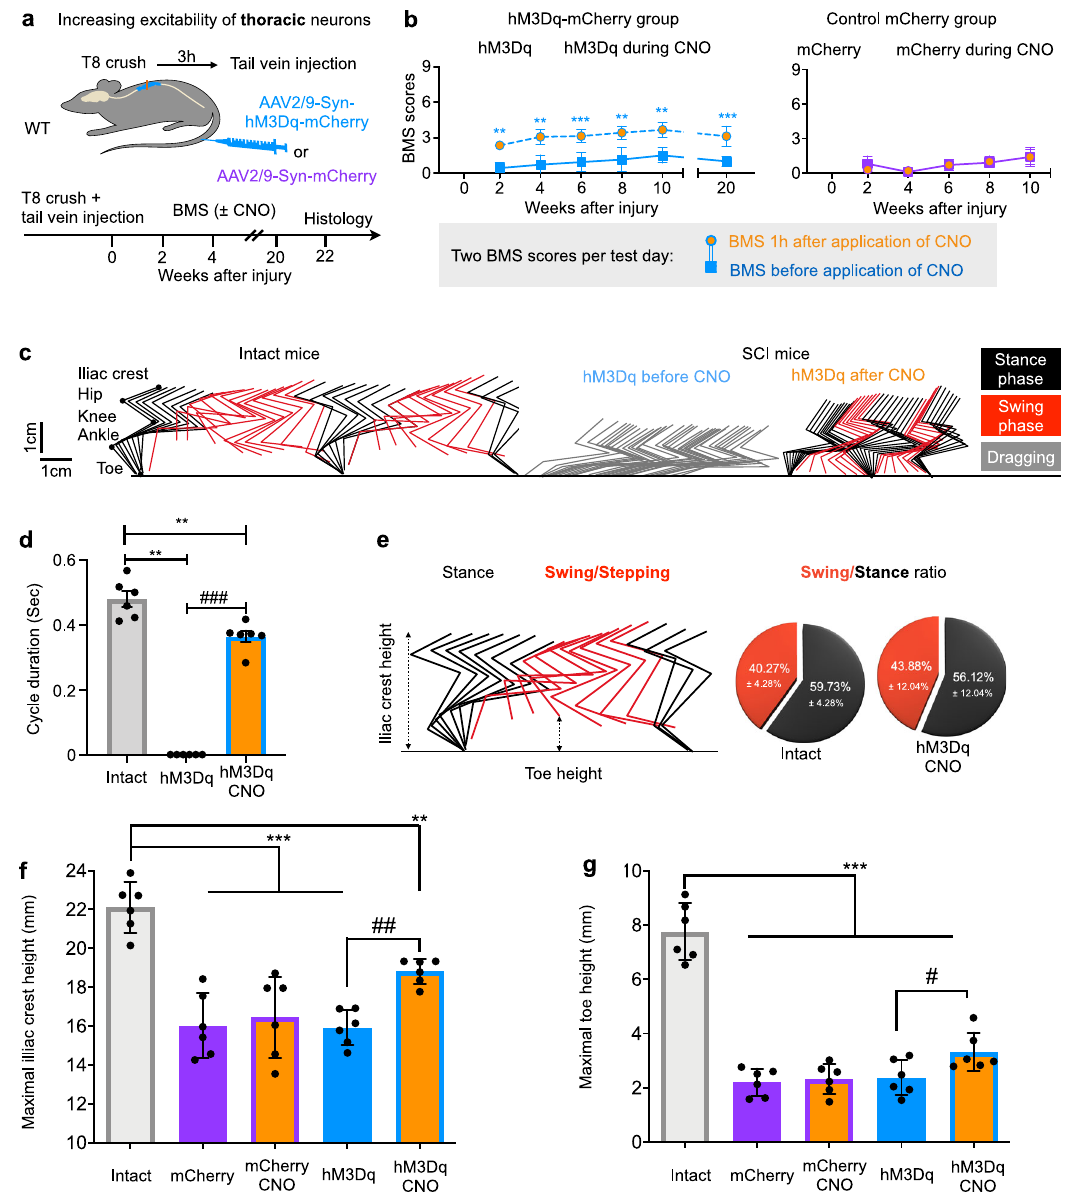
Fig. 2 hM3Dq-assisted activation of thoracic neurons elicits locomotion behaviour after T8 crush. a Experimental schematic. After a T8 crush injury, wild type (WT) mice received a tail vein injection of AAV2/9-Syn-hM3Dq-mCherry or control virus (AAV2/9-Syn-mCherry) and their locomotion behaviour was measured upon CNO administration every 2 weeks after injury. b BMS scores of injured mice with AAVs expressing hM3Dq-mCherry (left) or control mCherry (right) at indicated time points, before and 1 h after administration of 1 mg/kg CNO. hM3Dq-mCherry group: n = 7; Control group: n = 5. Data shown as mean ± SD (and also for other panels). Factorial Repeated Measures ANOVA with 2 within-subjects factors, followed by two-tailed paired t test at each time point. ns: no statistical difference, ** p = 0.0090 (2 weeks); 0.0081 (4 weeks); 0.0012 (8 weeks); 0.0029 (10 weeks), *** p < 0.0001 (6 weeks, 20 weeks). c Stickviews of kinematic hindlimb analysis of intact mouse and mouse with hM3Dq expression before and after CNO injection (1 mg/kg) at 4 weeks after injury. The phases of dragging, stance, or swing were marked in indicated colours. Cycle duration ( d ) and swing/ stance ratio ( e ) of intact mice and spinal cord injured mice with hM3Dq expression. Injured mice expressing hM3Dq dragged before CNO treatment, but had similar stance/swing phase distributions as intact mice (Bar chart) after CNO treatment. Two tailed paired t test for within-group comparison (#) and Wilcoxon rank sum for between-group comparison (*). ** p = 0.0022 (hM3Dq); 0.0043 (hM3Dq CNO) and ### p < 0.001. Quanti fi cation of the maximum iliac crest heights ( f ) and the maximum toe heights ( g ). One-Way ANOVA with Tukey ’ s post test for between-group (*) and two tailed paired t tests for within-group (#) comparsion. *** p < 0.001; ** p = 0.0039; ## p = 0.0040 ( f ); *** p < 0.001; # p = 0.0166. For ( d ) – ( g ), n = 6 for each